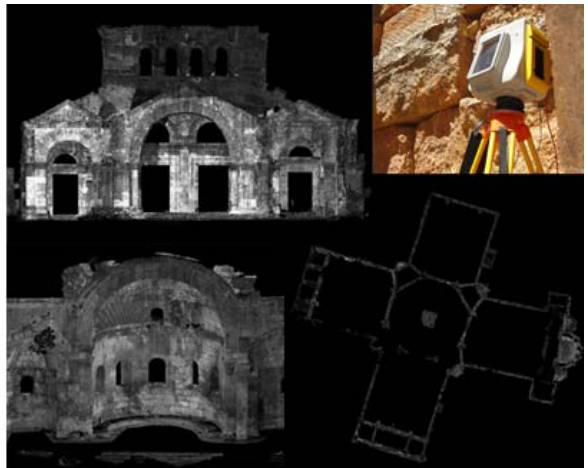
Figure 3.The point cloud of the church and the used scanner Based on these divisions and on the extracted profiles, a model of description of the building morphology was realized (Figure 3). In this case, the 3D model was done in a simplified way to show important deformations of the edifice without deepening in moulded elements (Figure